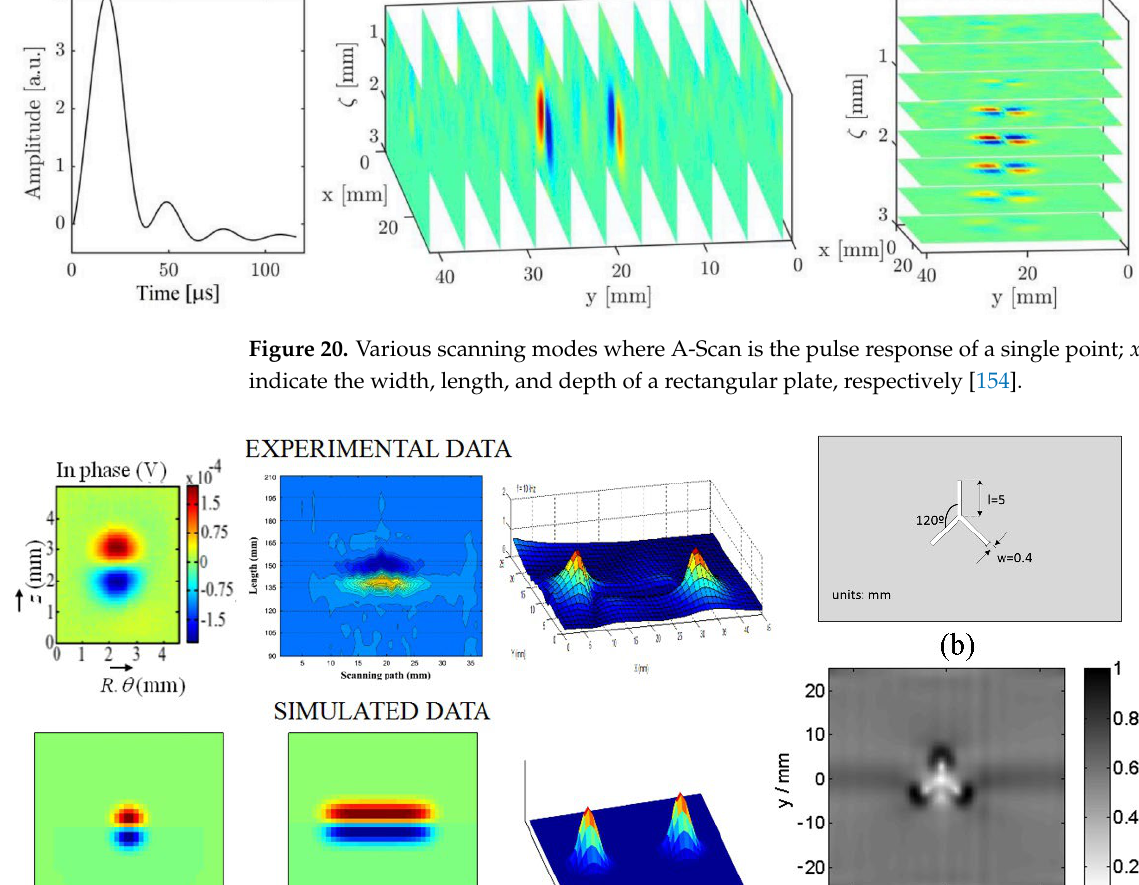
Figure 21. ( a ) Comparison between the measured magnetic field signal (experimental data) and HG 0.1 pattern (simulated data) [155]; ( b ) shape of defect; ( c ) normalized sum of Eddy current density distributions [147].